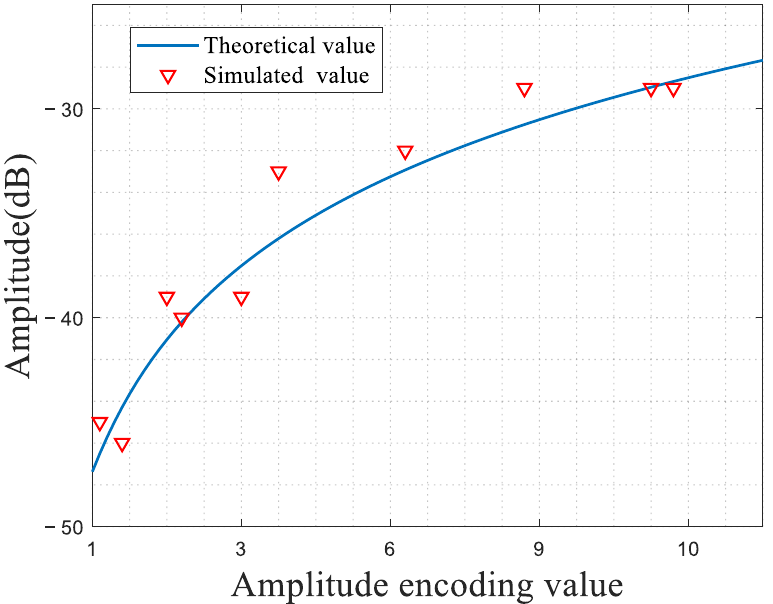
Figure 11. The amplitude corresponds to different amplitude encoding values for point 𝑃 3 .